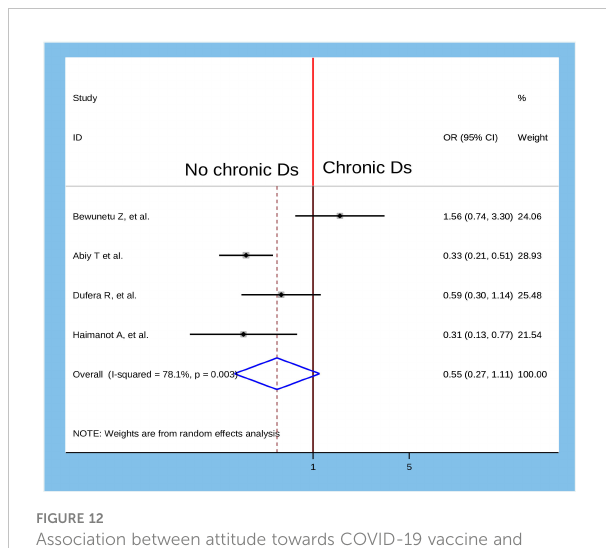
FIGURE 12 Association between attitude towards COVID-19 vaccine and willingness to accept COVID-19 vaccine in Ethiopia,